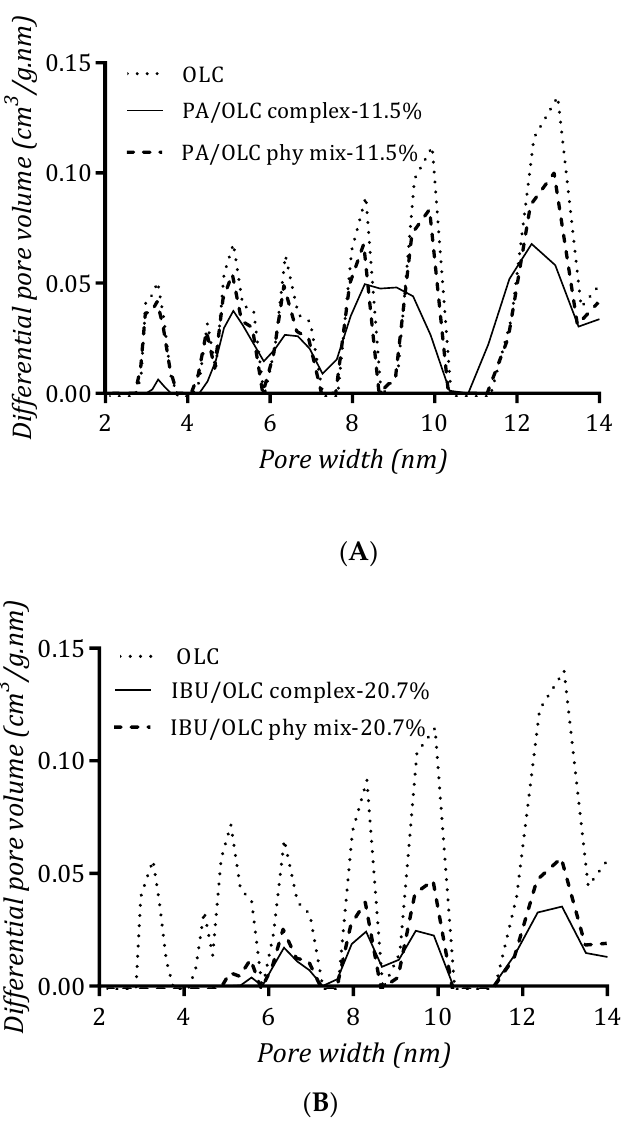
Figure 10. Pore size distribution (2–14 nm) calculated using NLDFT slit-shaped pore model of carbon onion (OLC) before and after drug loading showing- ( A ) paracetamol-loaded carbon onion (PA/OLC complex) and physical mixture of paracetamol and carbon onion (PA/OLC phy mix); ( B ) ibuprofen-loaded carbon onion (IBU/OLC complex) and physical mixture of ibuprofen and carbon onion (IBU/OLC phy mix).